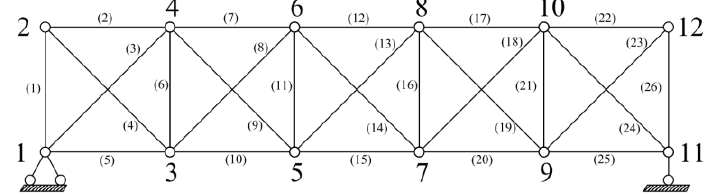
Figure 9. truss-type bridge model.